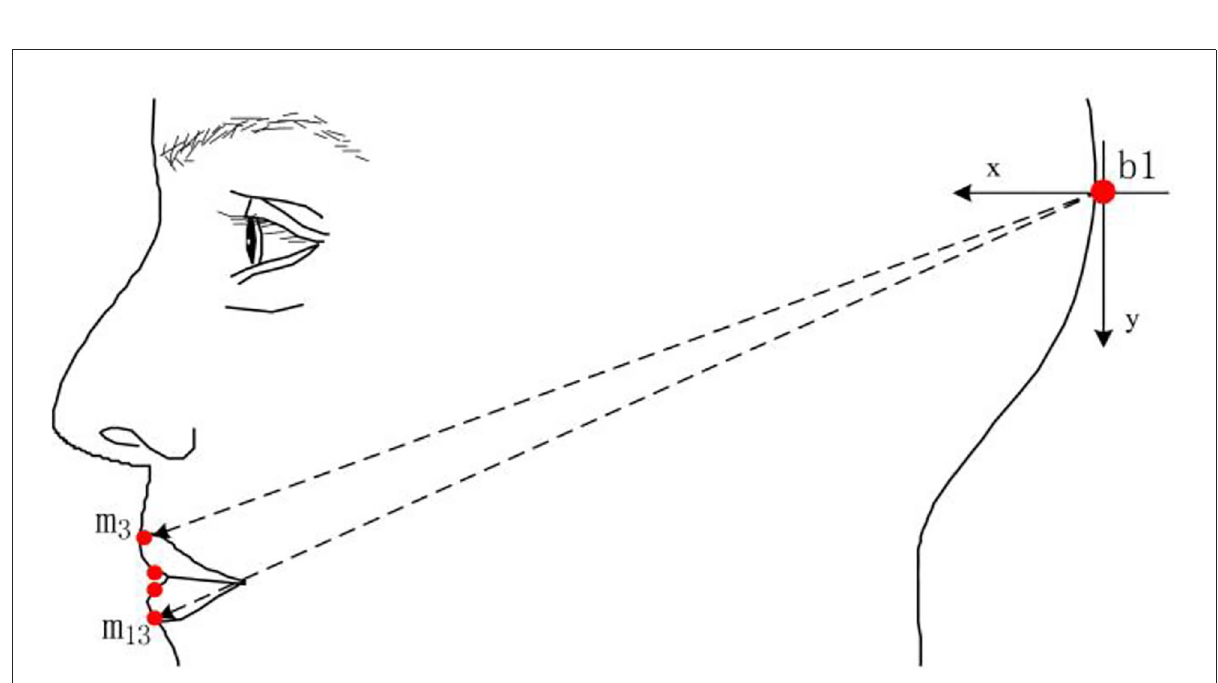
FIGURE5 The marked points of the lip protrusion defined by He